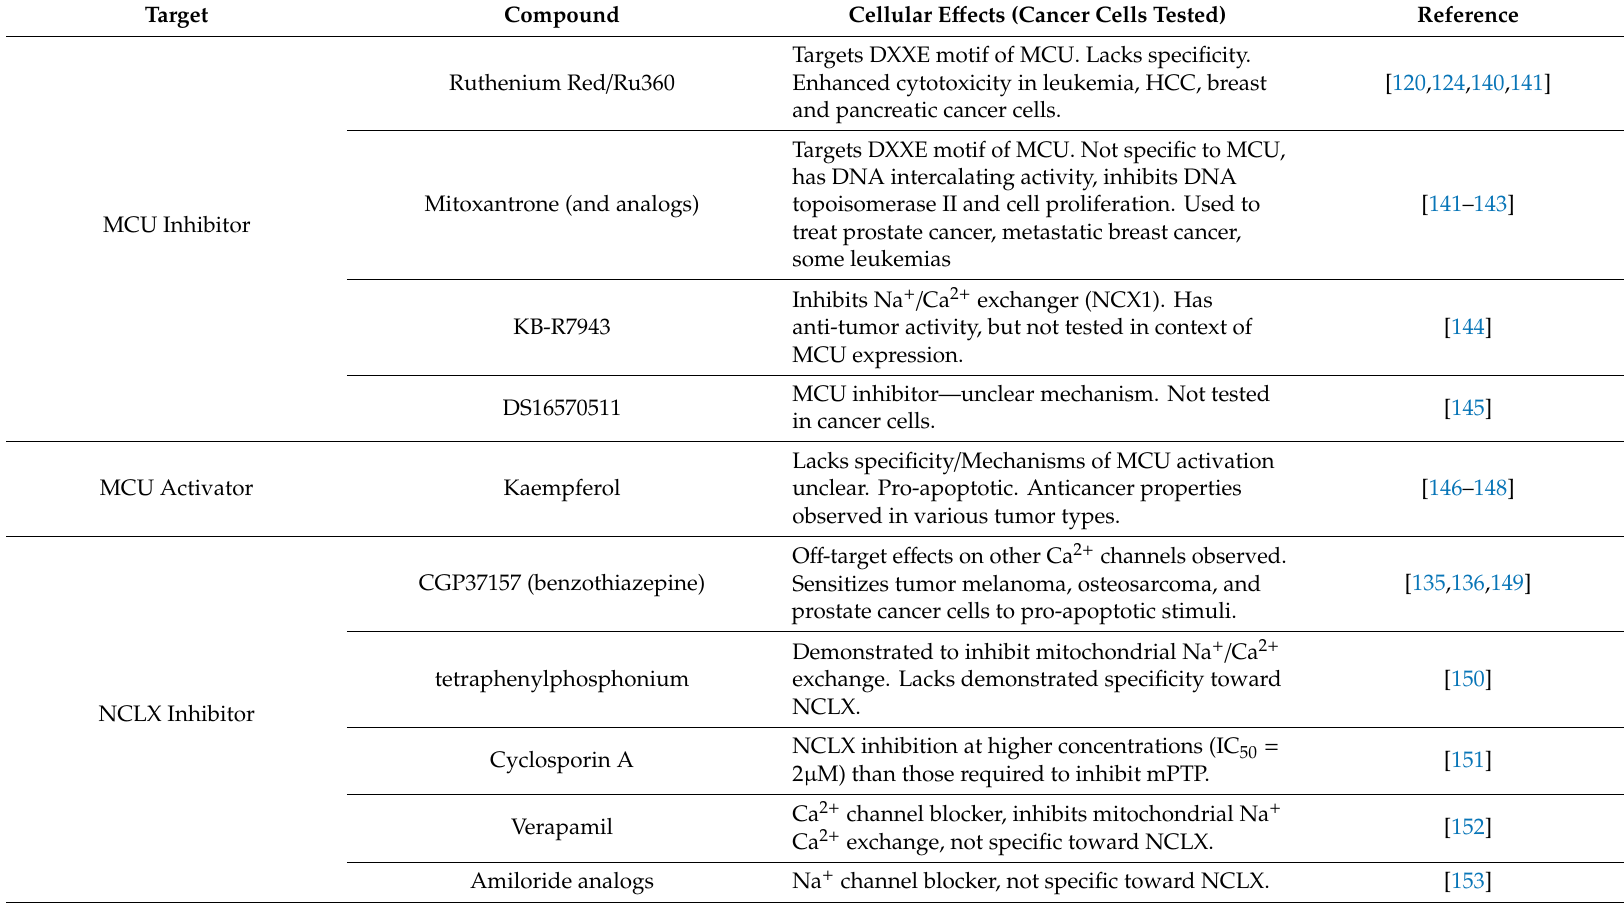
Table 2. Pharmacological targeting of [Ca 2 + ] m regulators of the